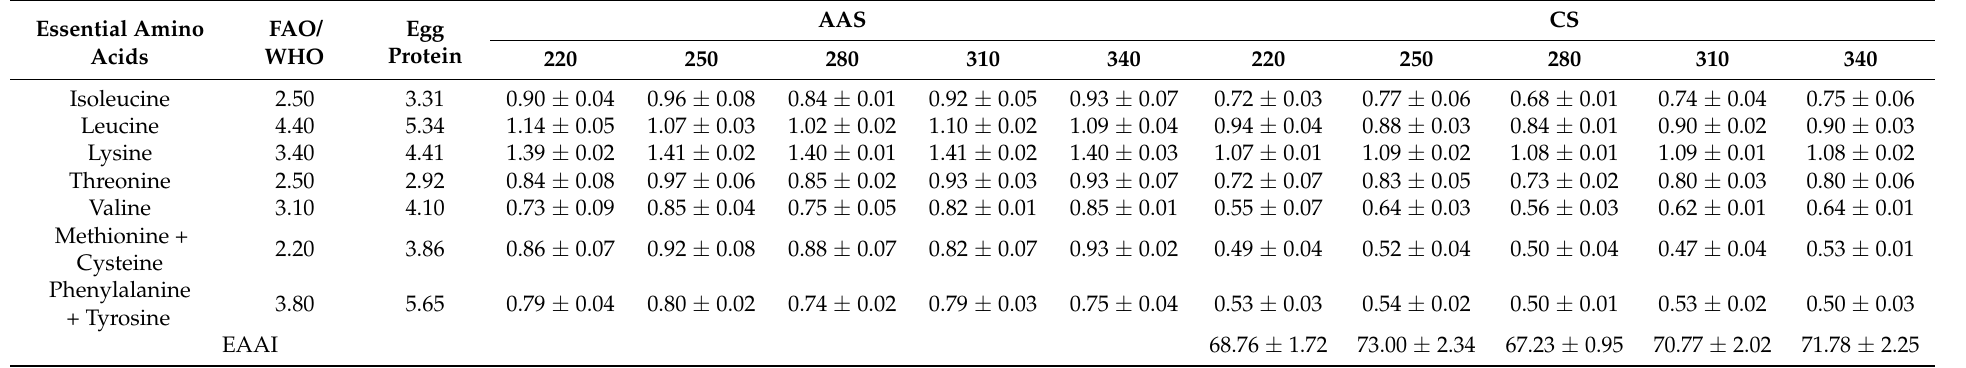
Table 7. Effects of different dietary protein levels on the protein quality evaluation of essential amino acids in Cyprinus carpio haematopterus